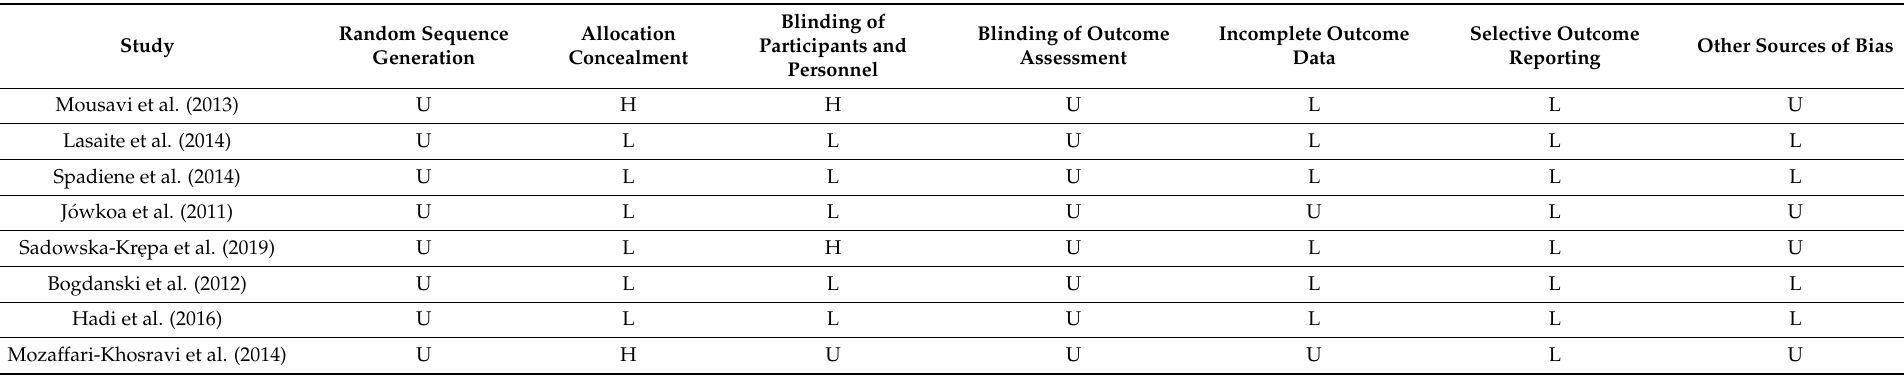
Table 2. Quality assessment of the